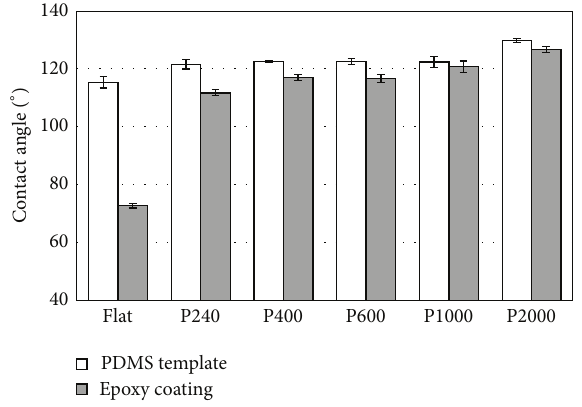
Figure 2: Water contact angles on PDMS templates and epoxy coatings.